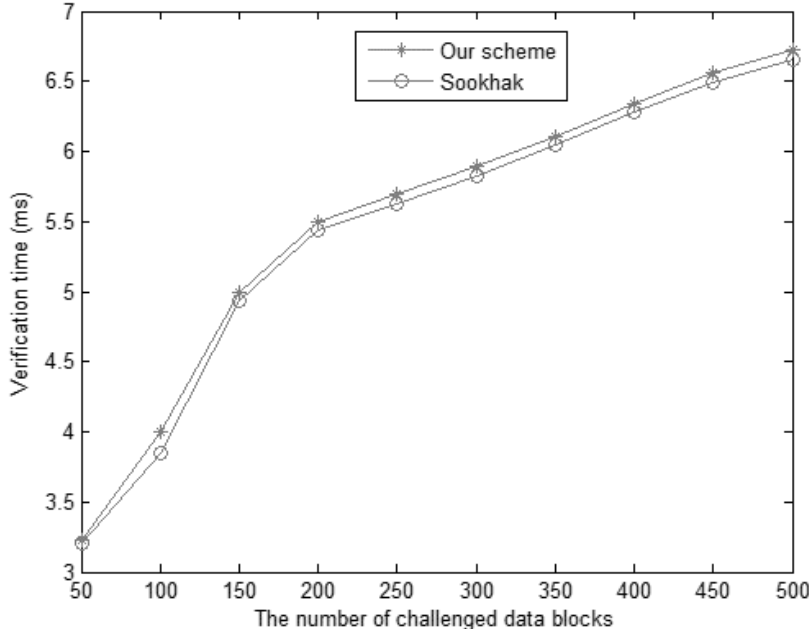
Figure 8. The verification time for different challenged data blocks.